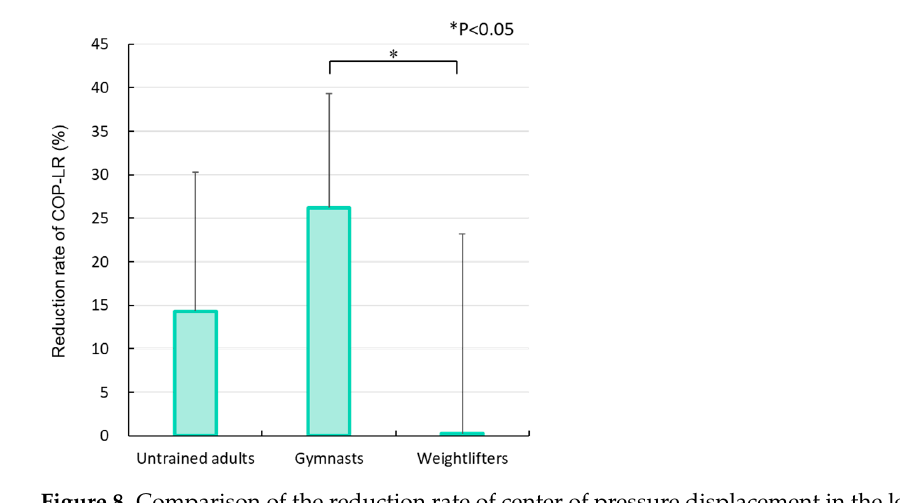
Figure 8. Comparison of the reduction rate of center of pressure displacement in the left-and-right direction (COP-LR) among participant groups when wearing mouthguards. Measurements are expressed as means ± SD. Error bar indicates standard error of the mean. * p < 0.05: denotes statistically significant difference.